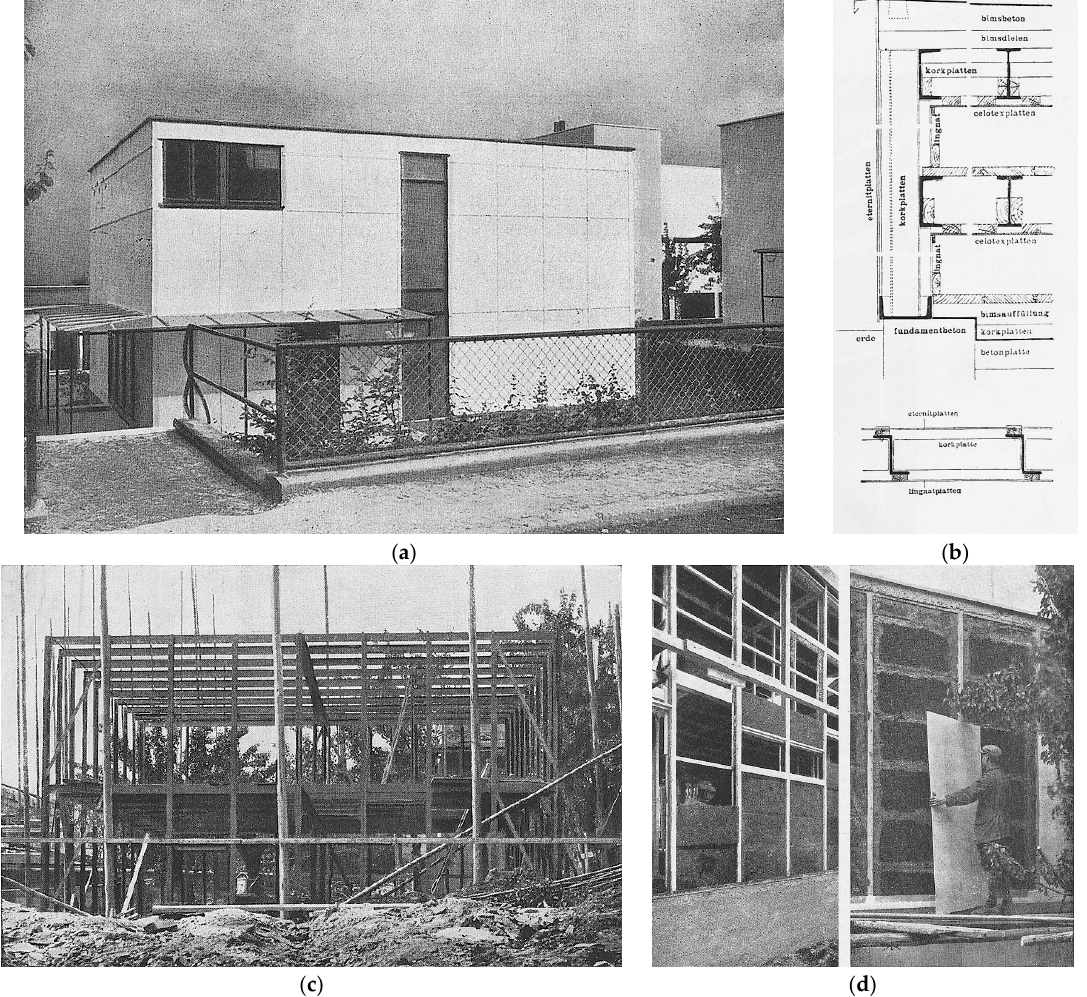
Figure 13. House number 17 at the Stuttgart Werkbund exhibition Am Weißenhof, 1926–1927—Photo of house, façade section, steel skeleton during construction and construction process. Images from (Gropius 1927a, pp. 63–65).